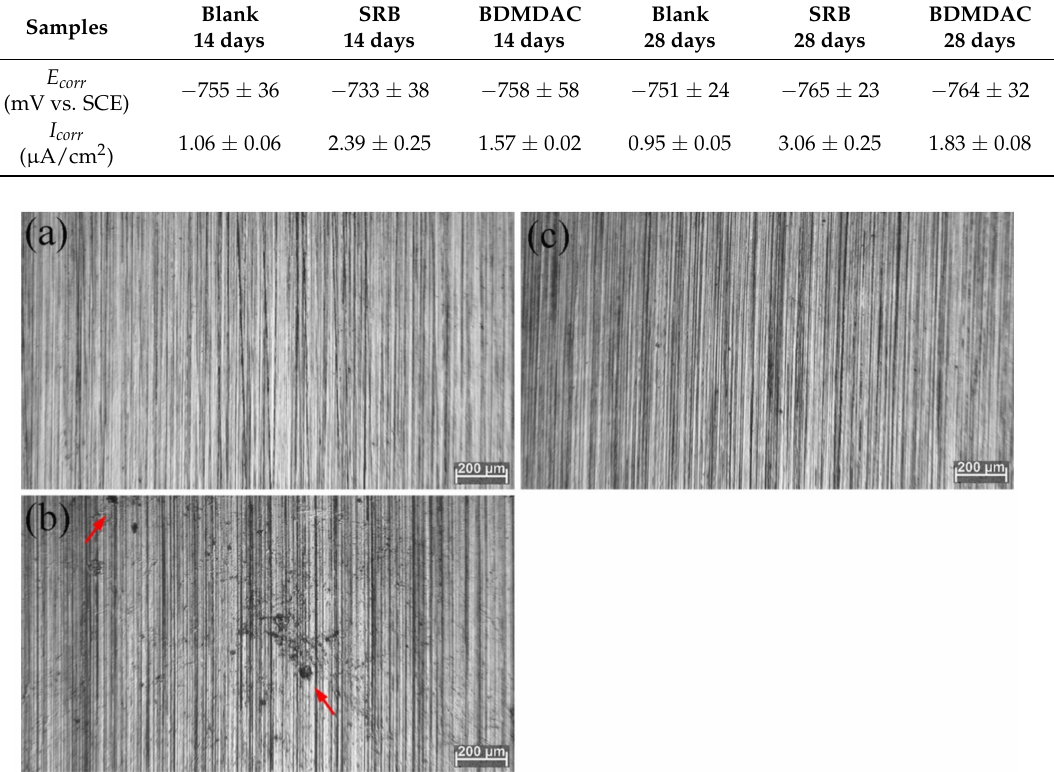
Figure 6. OM images of 304SS coupons after potentiodynamic polarization curve measurements. These surfaces were initially exposed to ( a ) blank for 14 days; ( b ) SRB for 14 days; and ( c ) BDMDAC for 14